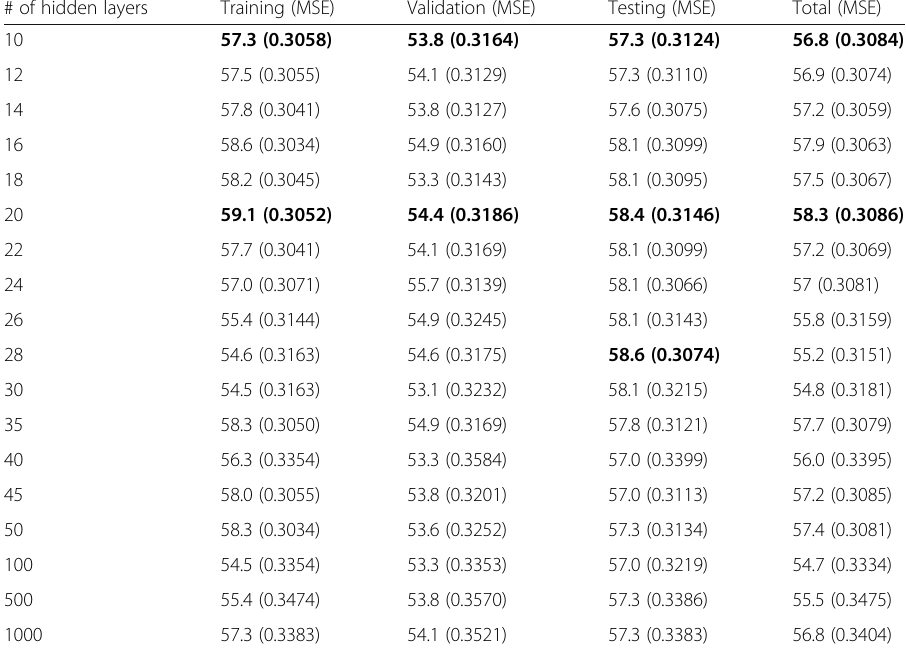
Table 2 Classification results with ANN/DNN classifiers using entire untransformed data # of hidden